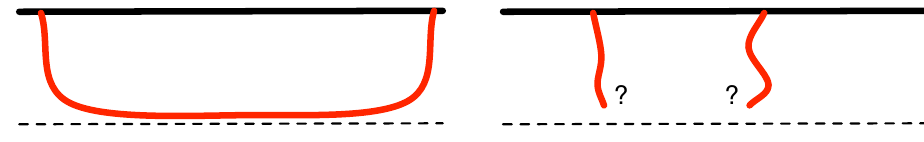
Figure 1 . (Left) Connected string con(cid:12)guration (thick red curve) in the calculation of the quark- antiquark potential in string theory. The top, continuous, black, horizontal line represents the boundary on which the gauge theory resides. The bottom, dashed, black, horizontal line is the place where the geometry ends smoothly. (Right) Disconnected con(cid:12)guration that is not allowed due to charge conservation, since the endpoints of the strings have no place to end.